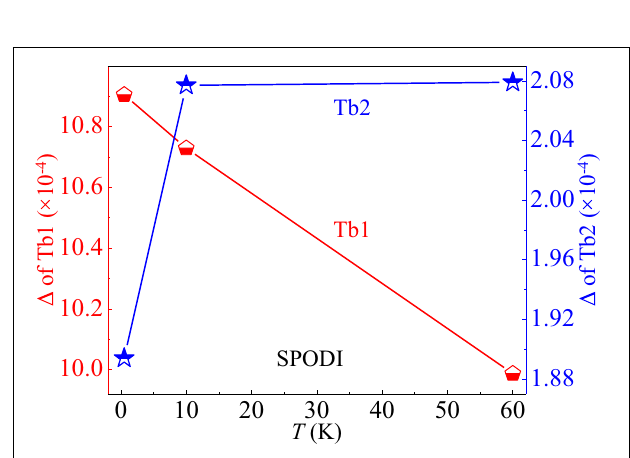
FIGURE 8 | Octahedral distortions of the Tb1 and Tb2 sites. Octahedral distortion parameter (cid:6) of the Tb1 (left ordinate) and Tb2 (right ordinate) sites as refined from the SPODI (FRM-II)